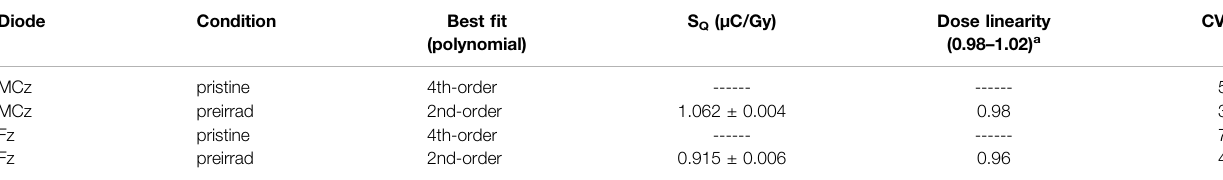
TABLE 2 | Relevant dosimetric parameters of MCz and Fz diodes.